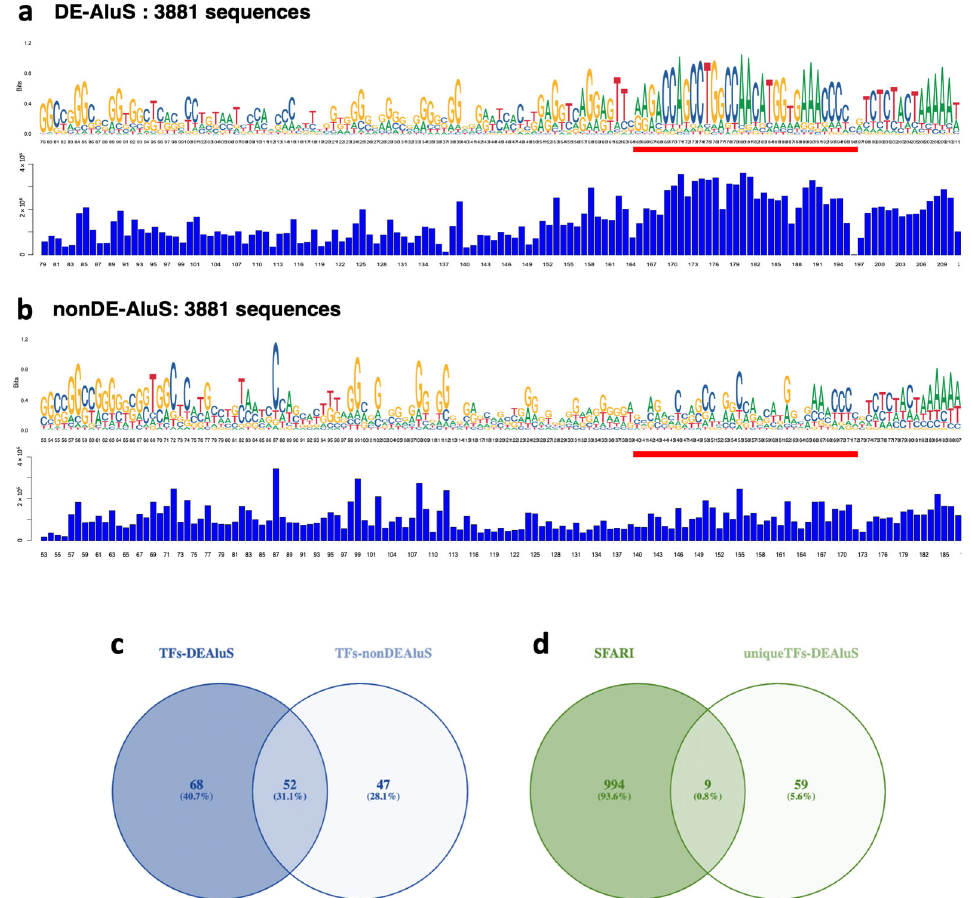
Figure 5. Consensus sequences and conservation scores of DE-AluS and non-DE-AluS. This figure shows the consensus sequence of the AluS family at the left arm of elements (containing the promoter region) of DE-AluS ( a ) and non-DE-AluS ( b ). Red lines highlight a conserved region for DE-Alu compared with non-DE-Alu. ( c ) A Venn diagram between predicted transcription factors binding to DE-AluS and non-DE-Alu. ( d ) A Venn diagram between unique transcription factors binding to DE ‐ AluS and SFARI genes.